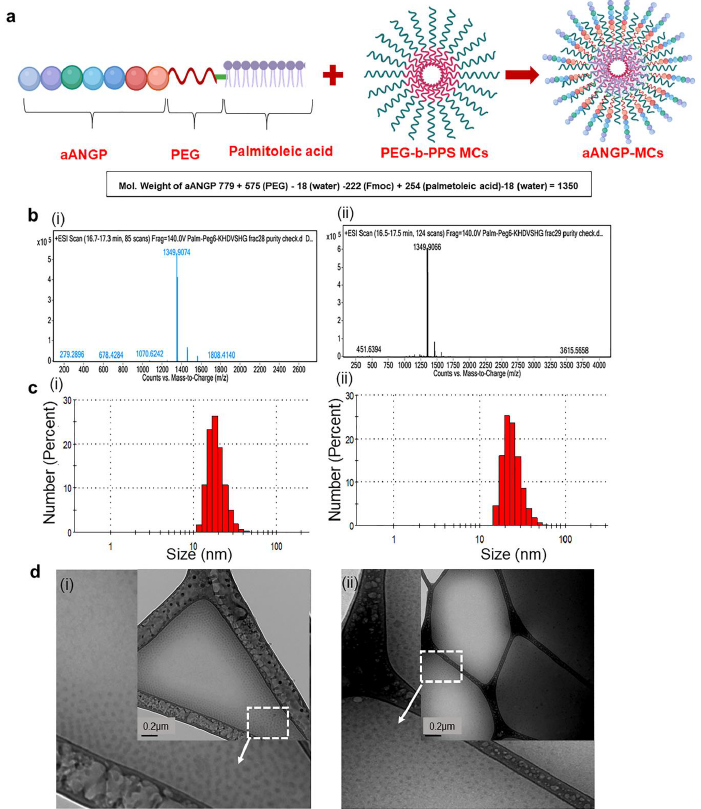
Figure 1. Design and characterization of aANGP-micellar delivery vehicle (MCs). ( a ) Schematic representation of the aANGP lipidated peptide construct and its insertion into poly (ethylene glycol)- b -poly (propylene sulfide) (PEG-b-PPS) MCs. ( b ) Total ion chromatograms of the fractions collected at retention times of 42 (i) and 45 (ii) min showing the peak obtained for the modified aANGP. ( c ) Dynamic Light Scattering (DLS) spectrum obtained for (i) PEG-b-PPS (blank) micelles and (ii) aANGP-MCs with the average particle size of 20–50 nm. ( d ) Cryogenic-Transmission Electron Microscopy (Cryo-TEM) images of (i) PEG-b-PPS (Blank) micelles and (ii) aANGP-MCs (inset) showed their respective morphology and size to both be spherical and 20–50 nm in diameter. Outer image is manually enlarged and cropped section of the white square part of the inset